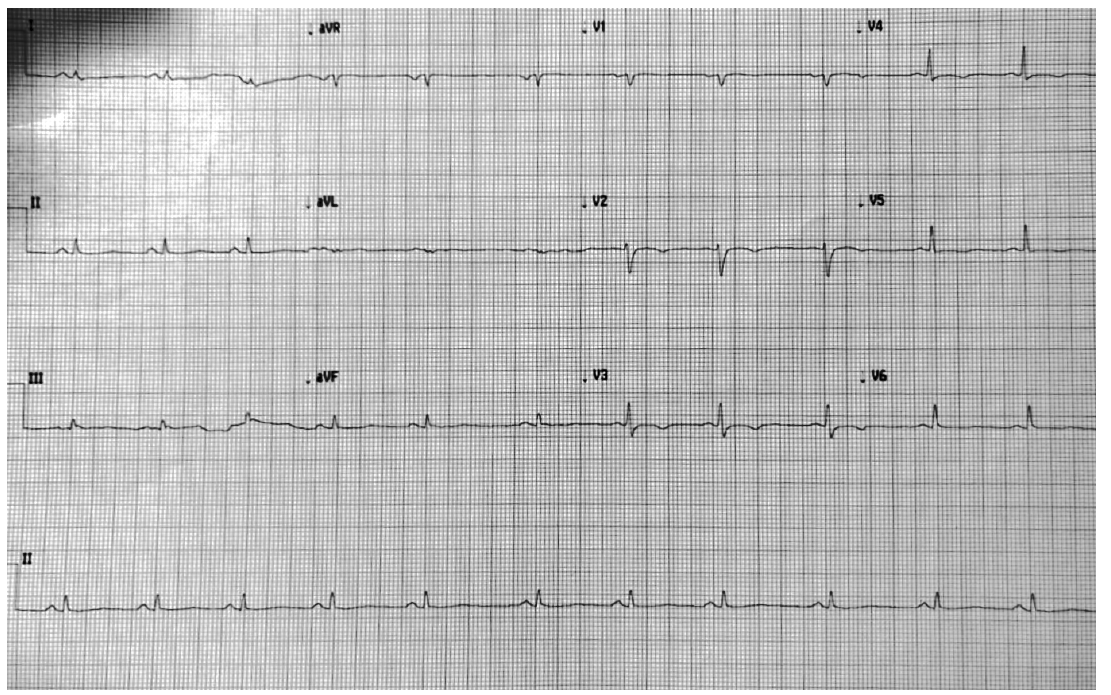
Figure 1. ECG showing diffuse repolarization abnormalities ad low voltages in limb leads.